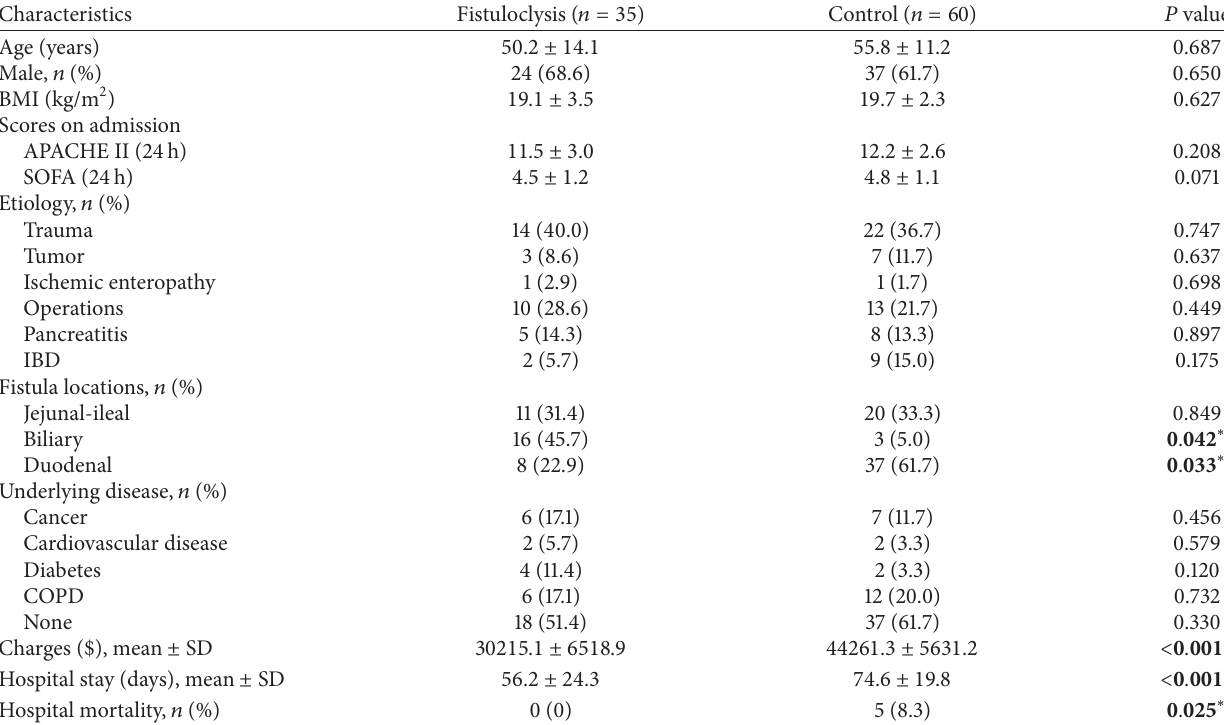
Table 1: Demographics and clinical characteristics of the two groups.